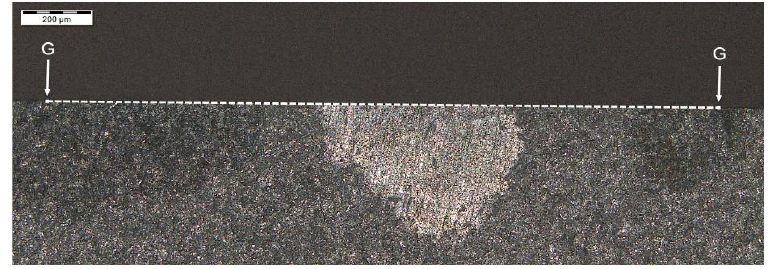
Figure 11. Waviness of carburized case depth. Magnification: 12.5×. Cross-section F-F, zone: 3A. Etched sample — Nital 5%.